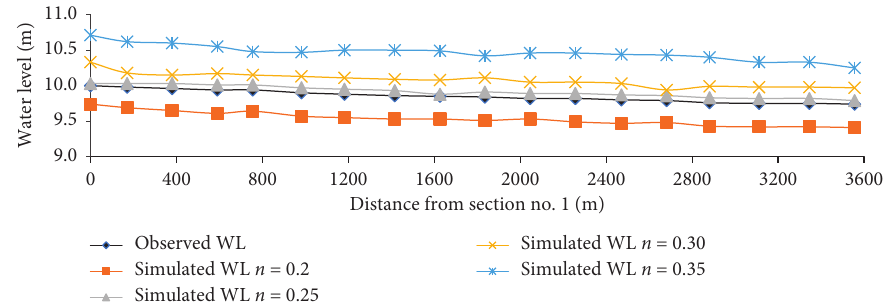
Figure 6: Observed and simulated water surface profile.